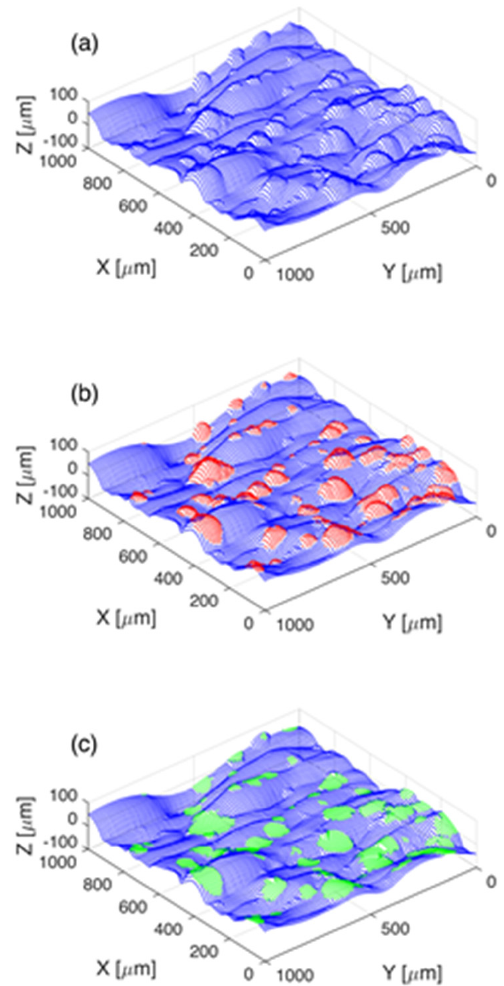
Figure 2. Spatter removing procedure; ( a ) original 3D profile normalized, ( b ) identified spatters (red), ( c ) removed spatters, the void regions (green) are filled and reconstructed.